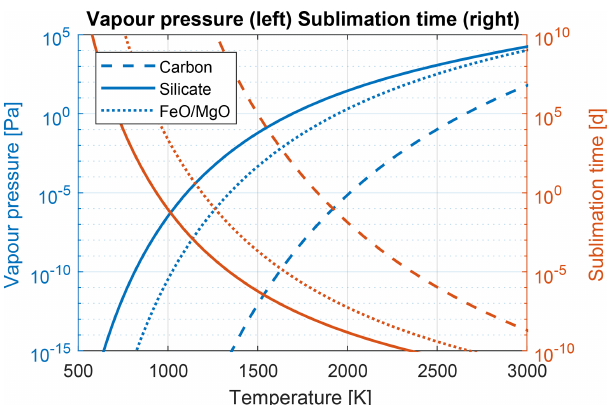
Figure 8. Vapour pressure (blue) and corresponding sublimation lifetime (orange) as a function of 1nm dust temperature; line styles indicate dust composition (carbon – dashed, astronomical silicate – solid, Fe 0 . 4 Mg 0 . 6 O –